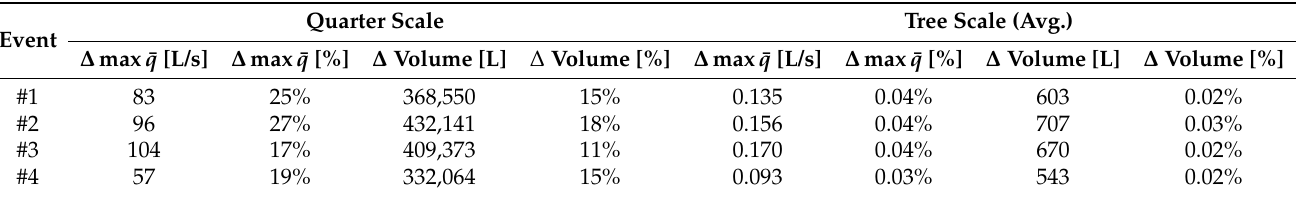
Table 5. Results of the model experiments considering runs with and without trees. The values indicate the increase in peak runoff and volume if trees are not included in the simulation. Tree Scale